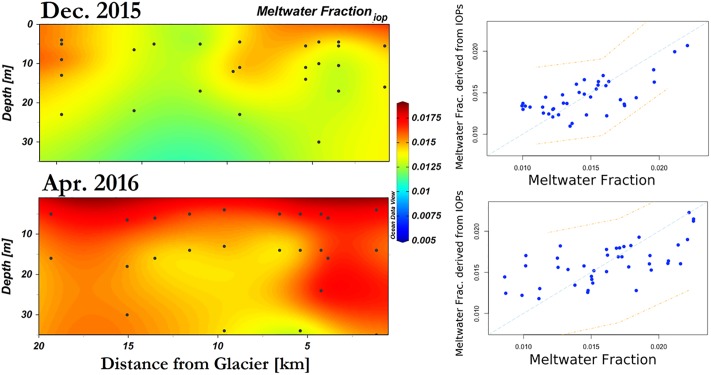
Section plots of meltwater fraction predicted based on Model 1 results.Left panels depict cross section plots of derived meltwater fraction from Model 1, which utilizes inherent optical properties–particulate backscattering coefficient at 442nm, non-algal particle absorption coefficient at 442nm, as well as temperature. Right panels depict their correlation with measured meltwater fraction based on oxygen-18 isotope ratios; orange dash lines indicate prediction intervals at 95% confidence.